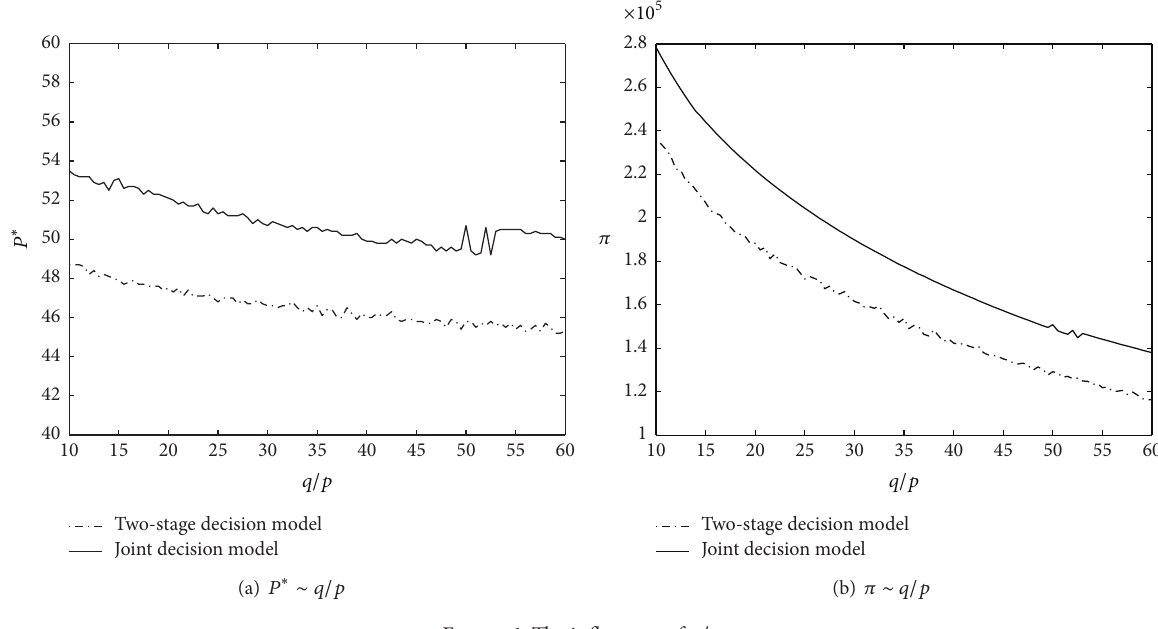
Figure 1: The influences of 𝑞/𝑝